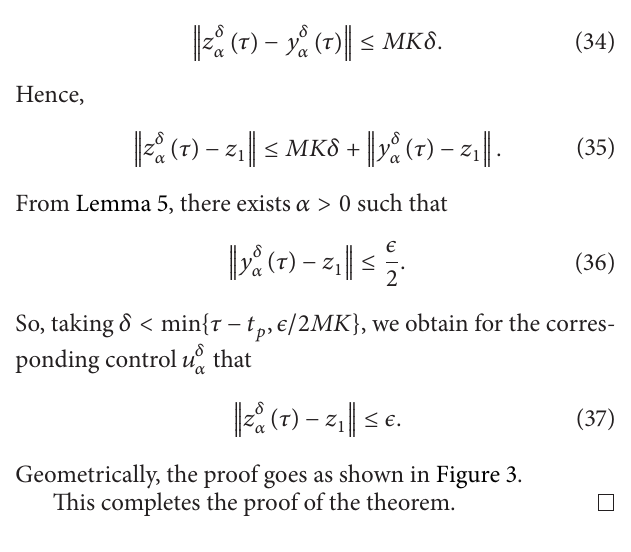
4.1. Abstract Formulation of the Problem. In this part, we will choose the space where this problem will be set up as